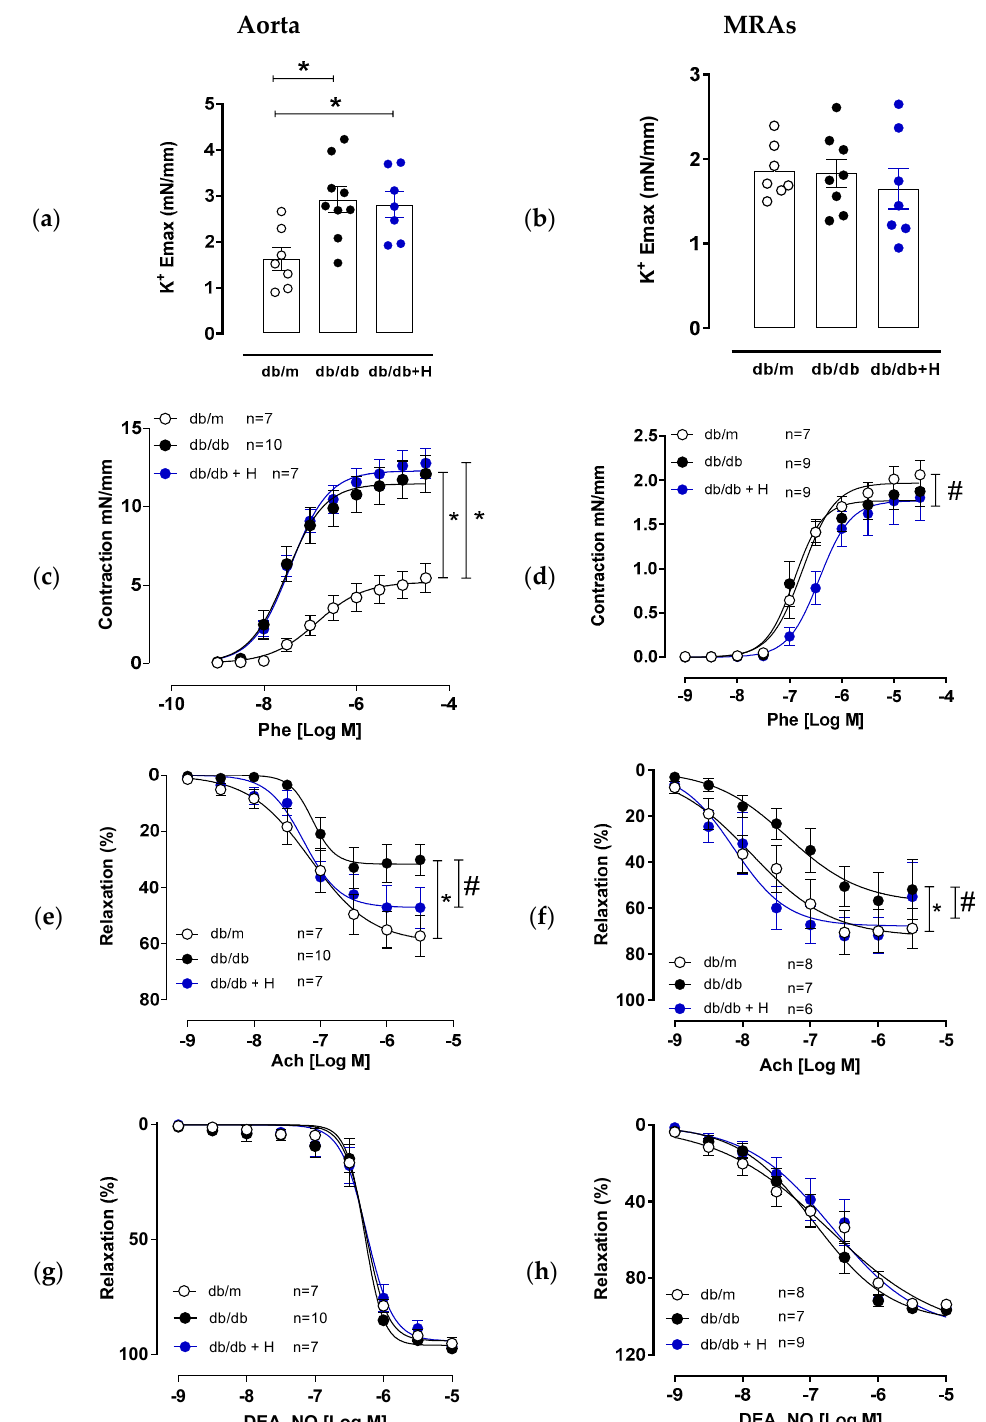
Figure 1. Effect of hidrosmin treatment in vascular function of aorta and mesenteric arteries from db/db mouse model. Maximum responses to high K + concentration in aorta ( a ) and mesenteric resistance arteries (MRAs) ( b ) from non-diabetic (db/m), untreated diabetic (db/db) and hidrosmin- treated diabetic (db/db + H) mice. Graphs represent individual data and the mean ± SEM of each group (db/m, n = 7; db/db, n = 8–9; db/db + H, n = 7) * p < 0.05 vs. db/m by Kruskal–Wallis, followed by Dunn’s post-test. ( c – h ) Concentration–response curves to phenylephrine (Phe), acetylcholine (Ach) and diethylamine NONOate (DEA-NO) of aortas ( c , e , g ) and mesenteric arteries ( d , f , h ). Graphs represent the mean ± SEM of the indicated number of animals per group. * p < 0.05 vs. db/m and # p < 0.05 vs. db/db by two-way ANOVA followed by Bonferroni’s post-test.